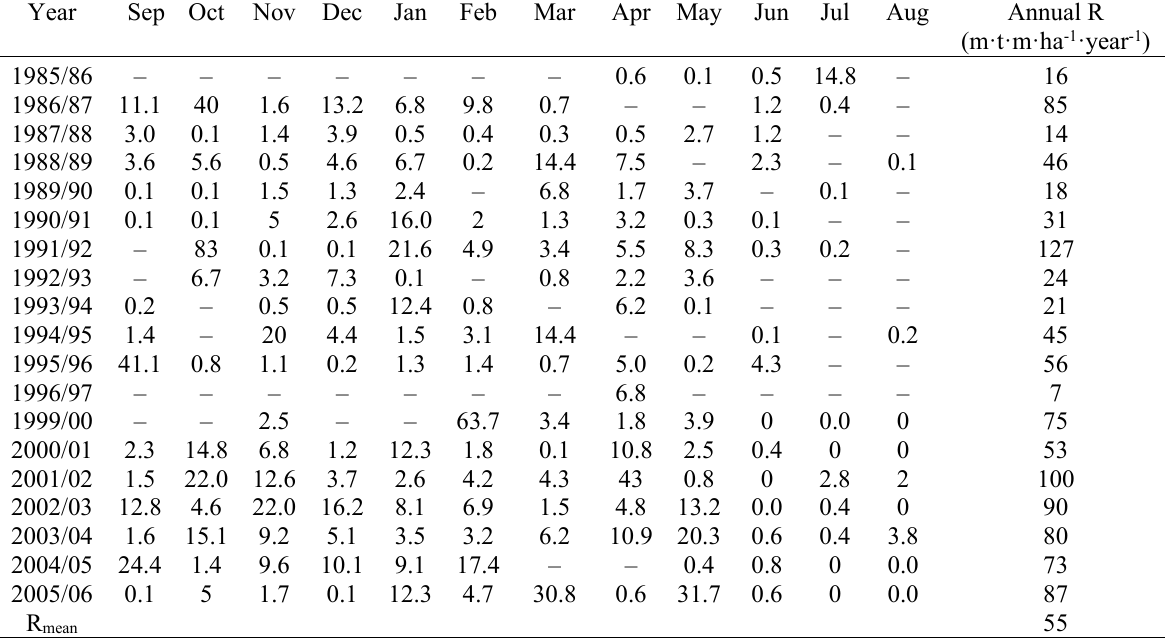
Table 3 Monthly and annual distribution of the erosion index R for 744 storms registered in the period 1985/1986 to